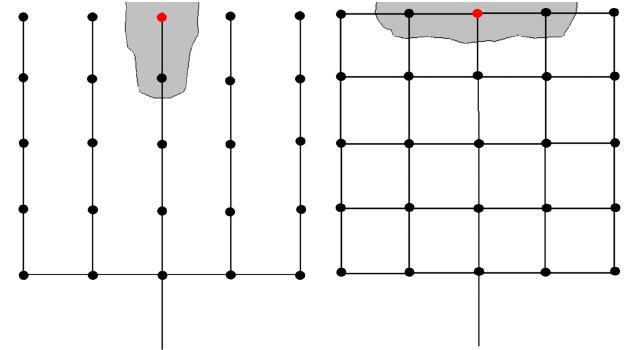
Figure 7. Contour plot of the pressure head drop caused by the opening of the H1 hydrant (red dot) in A model grid network (left) and L network (right). The area of the reduced pressure head (0.8 m H 2 O) is marked in grey.